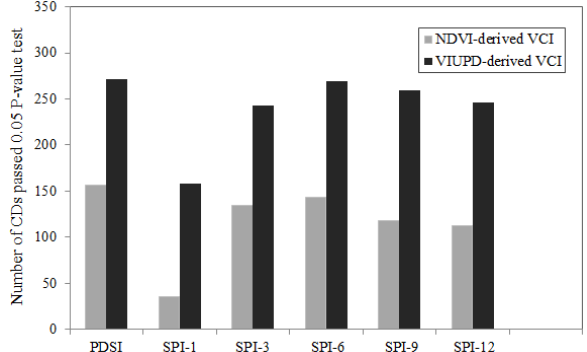
Figure 4. The number of climate divisions (CDs) passed at least p -value of 0.05 for testing statistical significance when comparing VI-based VCIs and station-based drought indices. X -axis stands for the station based drought indices which NDVI and VIUPD-derived VCIs are correlated to. Y -axis stands for the number of CDs which passed at least p -value of 0.05 for testing statistical significance.